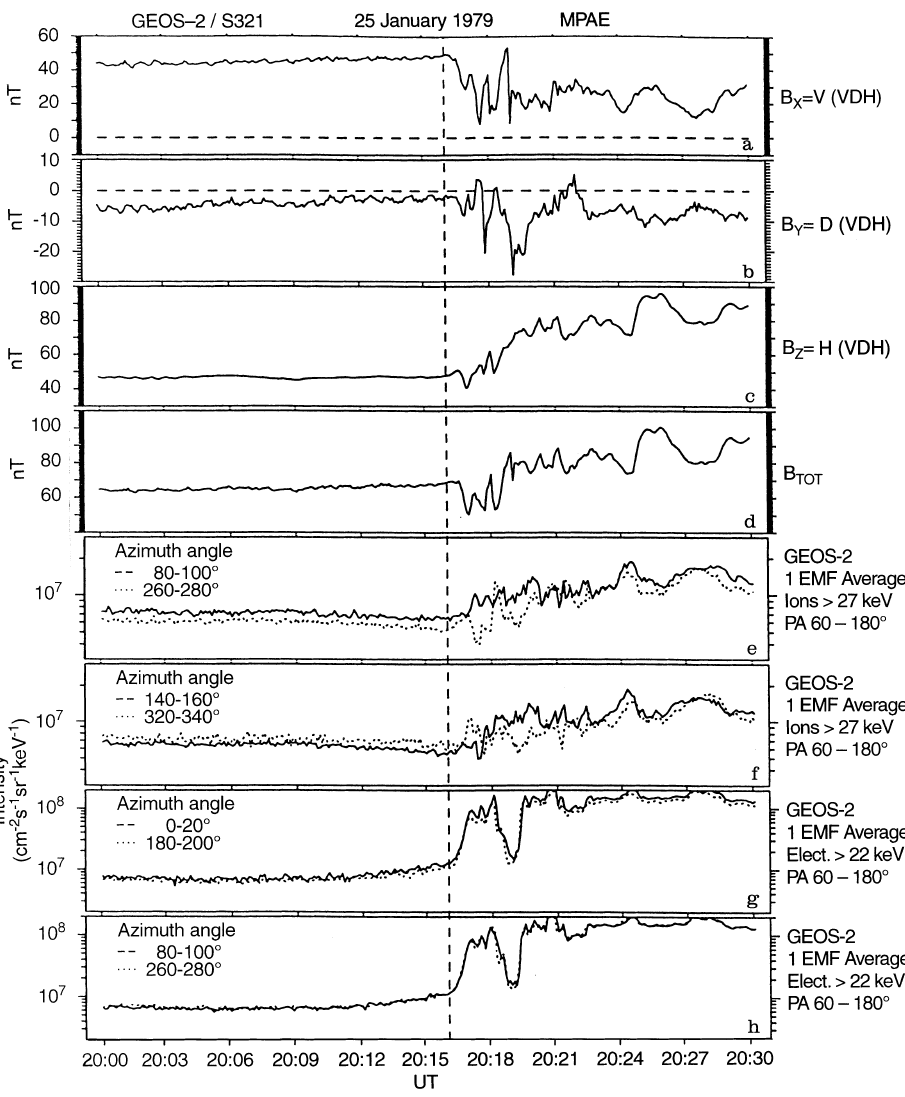
Fig. 4a – h. Event on 25 January 1979: a – d magnetic field in VDH components, e and f integral ions at two opposite azimuths, g and h integral electrons at the